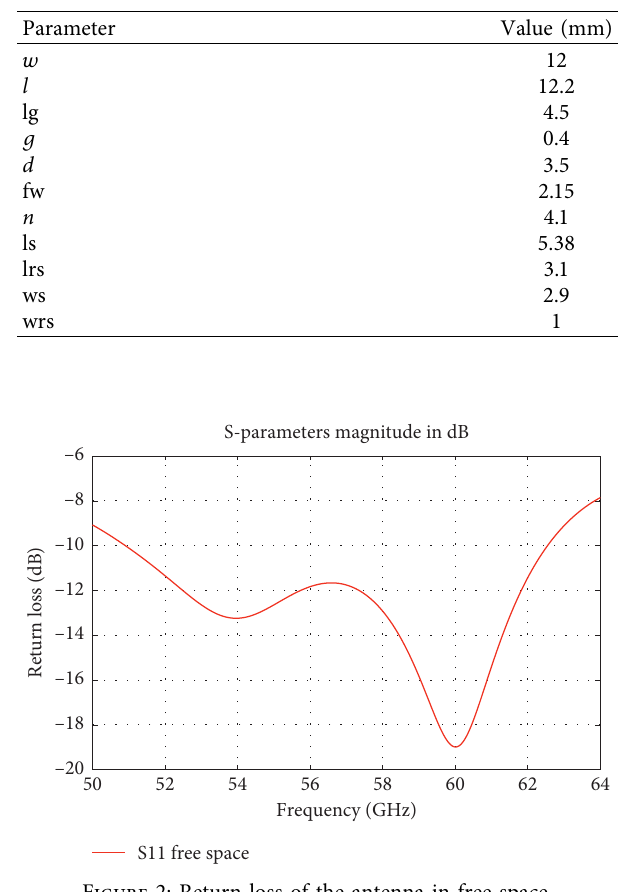
(Figure 8). Gain remained unchanged, but the radiation